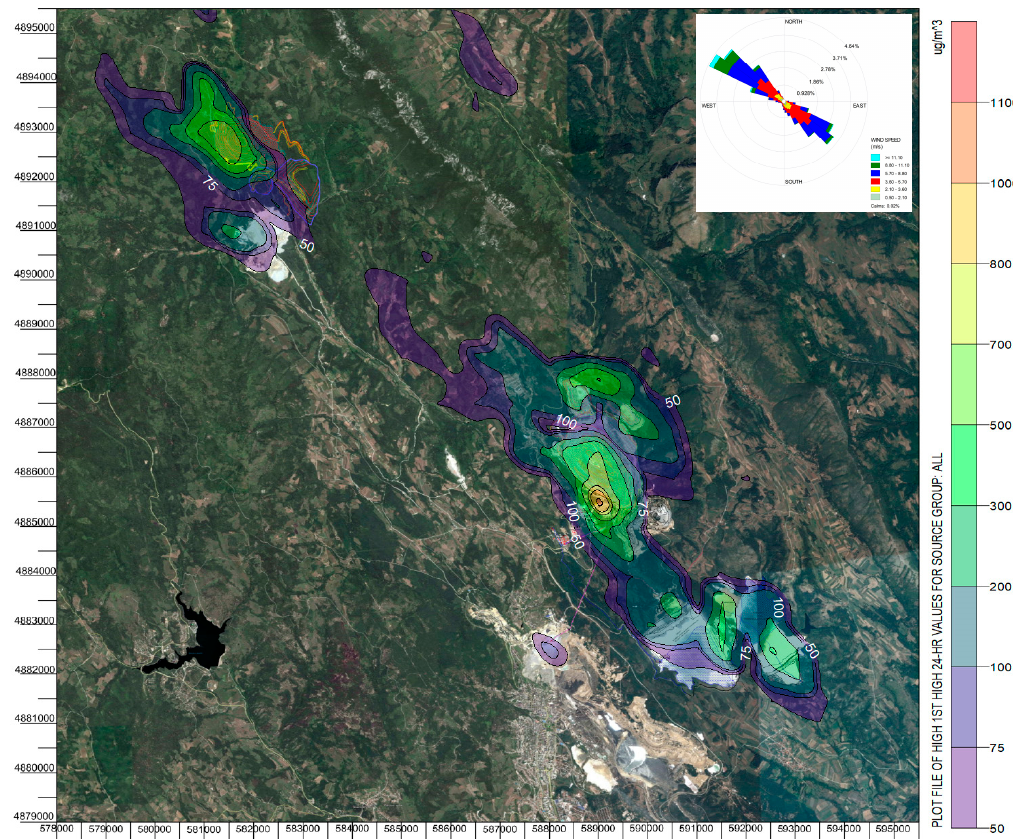
Figure 6. Distribution of PM10 ( μ g/m 3 ) particles concentration around the Veliki Krivelj and Cerovo open pits, with dust suppression and mitigation measures.